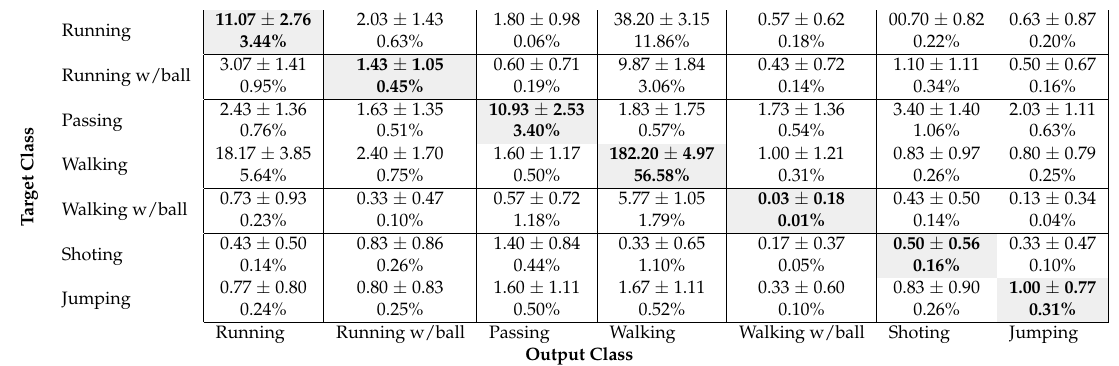
Table 7. LSTM Confusion